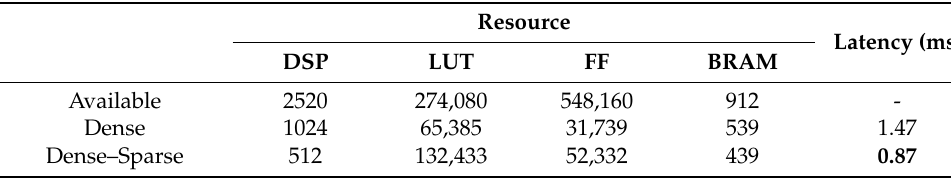
Table 4. Resource Utilization Report and Latency of Accelerators.